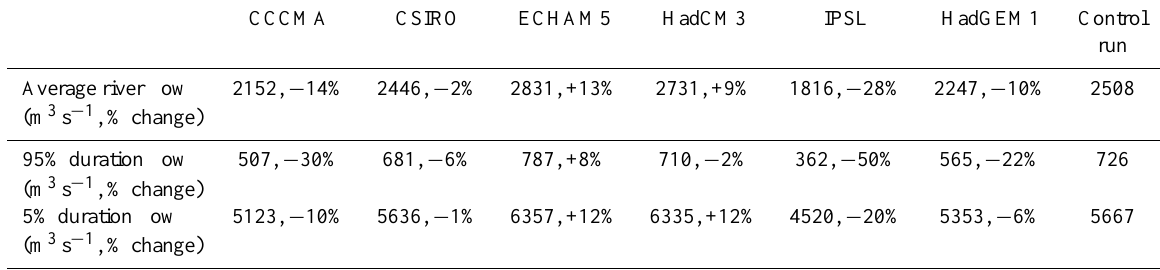
Table 5. Hydrological modelling results using the same greenhouse emission scenario (A1B) and projections from different global circulation models. Control run was calculated using 95 years, from 2006 to 2100.